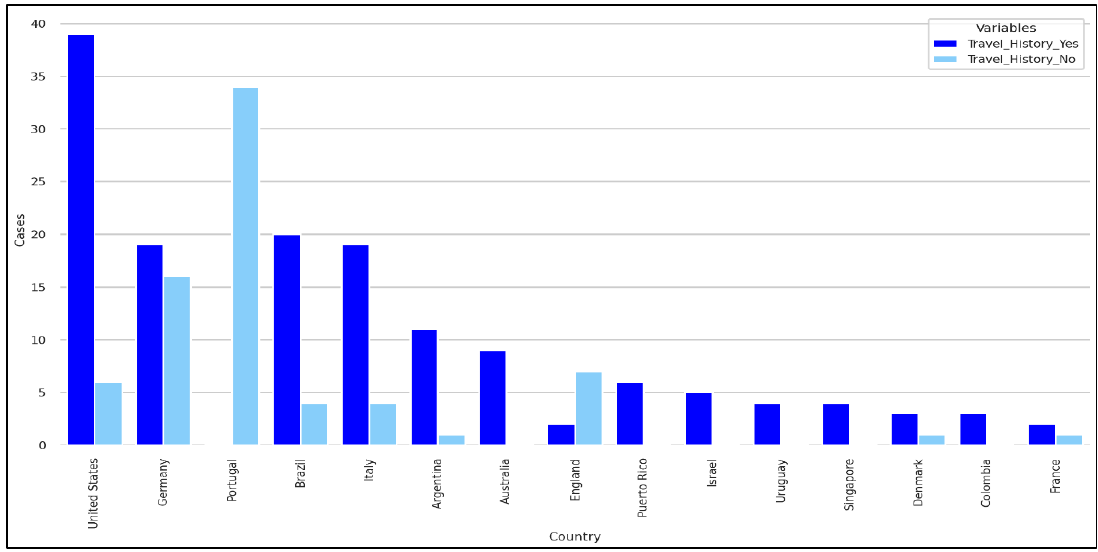
Figure 3. ( a ) Worldwide distribution of confirmed cases; ( b ) European distribution of confirmed cases; ( c ) Asian distribution of confirmed cases.